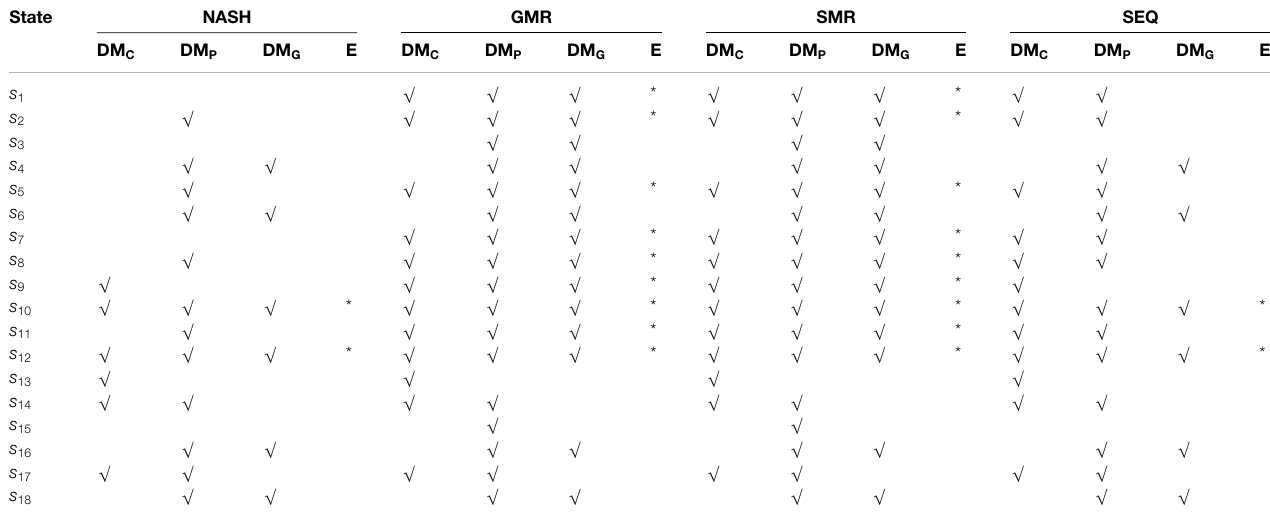
TABLE 5 | Equilibriums of ternary con fl ict in coal- fi red power industry chain.